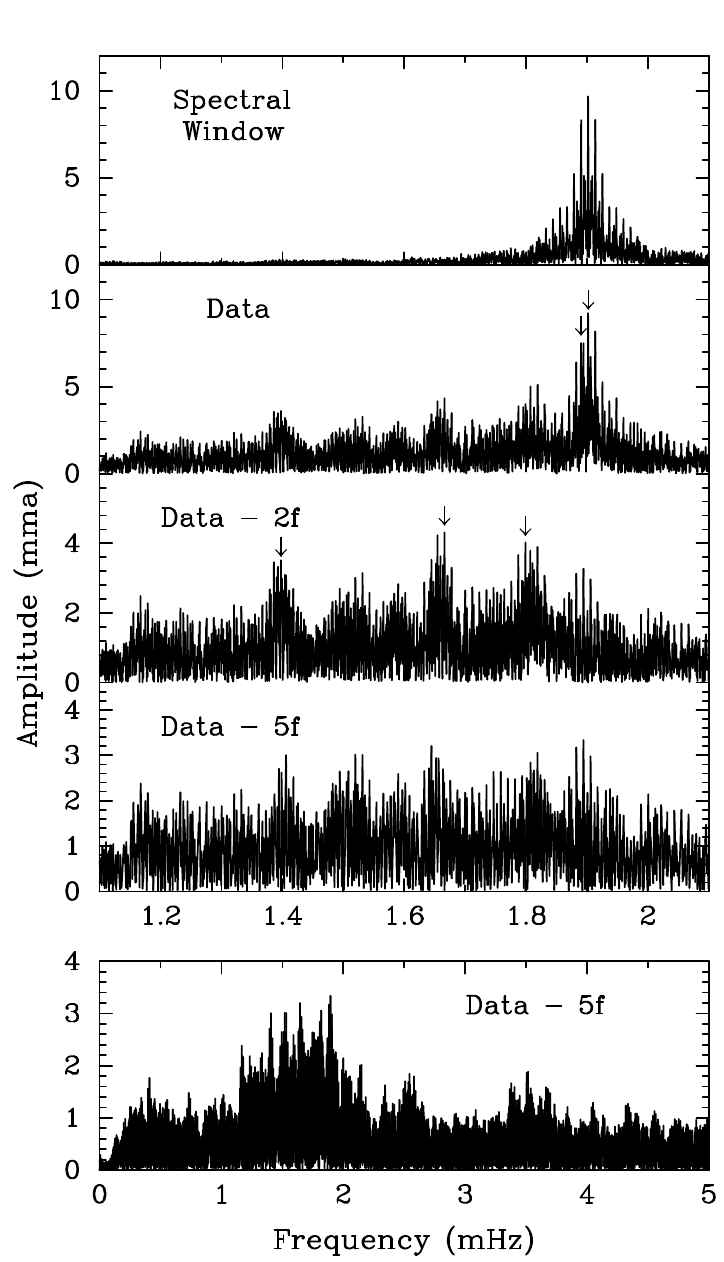
Fig. 4. Fourier spectral window and amplitude spectra of the XCov20 observations of KUV 05134+2605. Some trial prewhitening (of signals in- dicated with arrows) is shown to demonstrate the richness of the pulsation spectrum. This figure was adapted from Handler et al.